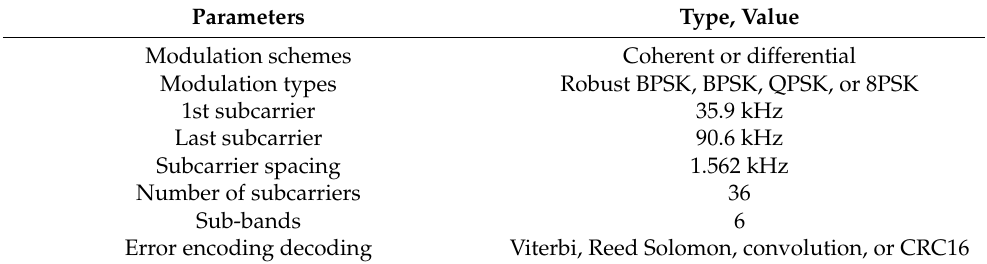
Table 1. Parameters of PL360 Evaluation kit—G3-PLC.